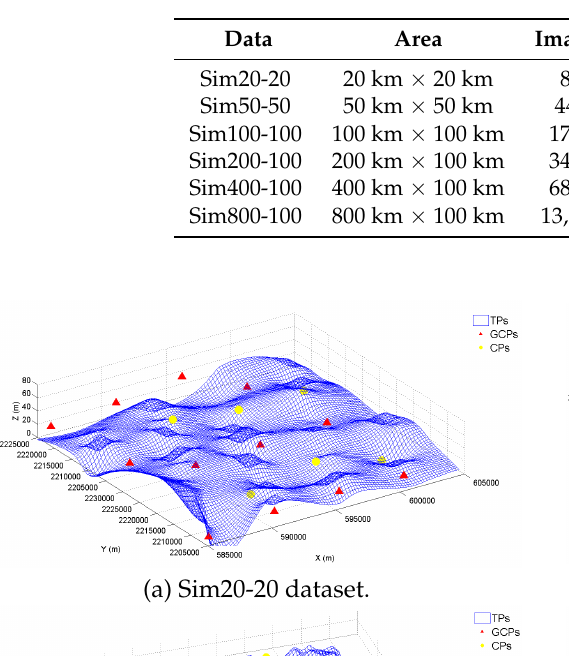
Table 1. The parameters of the synthetic datasets. CP, check point.